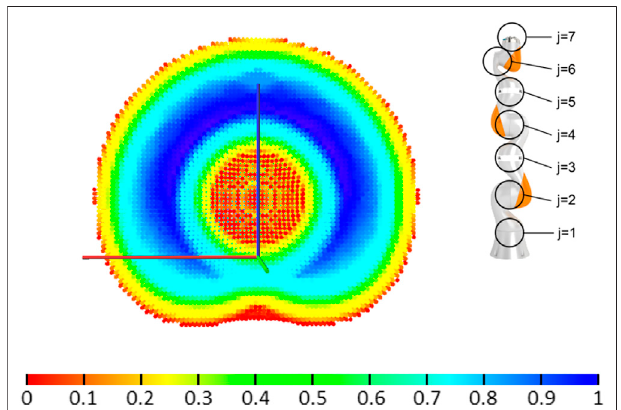
FIGURE 2 | Cross-section of the capability map for a KUKA iiwa robot, withsevenDoF(joints j aremarkedinthe fi gure).TheHSVcolorscaleencodes the reachability index R given by Eq. 1 . Map and robot are plotted at the same